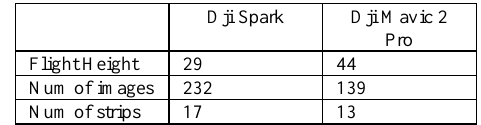
Table 3. Comparison between survey flight project of an ultra- light UAV (Dji spark) and other systems (Dji Mavic 2 pro)